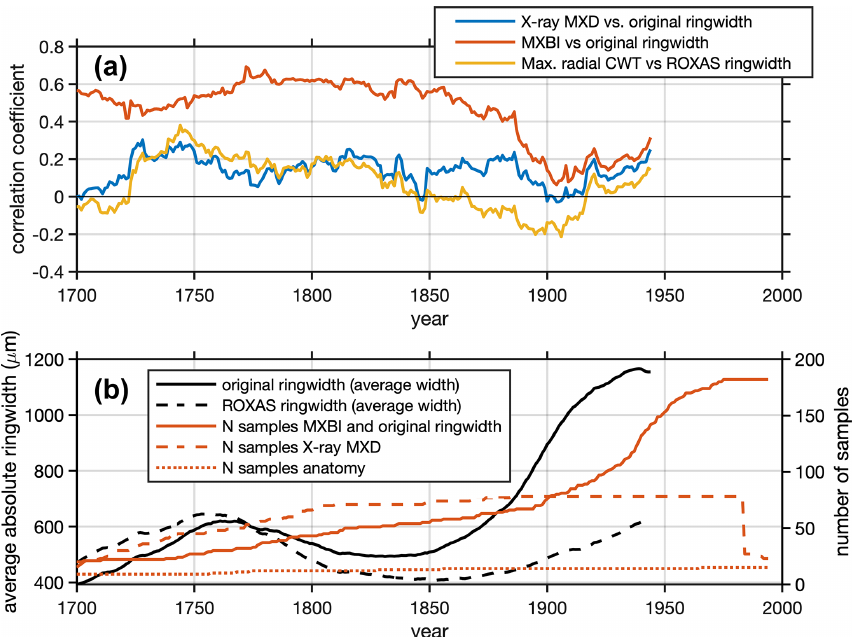
Figure 8. (a) Running Pearson’s correlation (a 50-year window shifted by 1 year) between selected density parameters and ring width. The years on the x axis show the first year of the 50-year correlation windows. Note that for X-ray MXD, the ring width data are not obtained from the same tree cores as have been used for the density measurements, which is otherwise the case for both MXBI and anatomy. (b) Running average of absolute ring widths (original and ROXAS datasets) computed using a 50-year window shifted by 1 year, together with the chronology sample depths of the X-ray MXD, MXBI and dendroanatomical